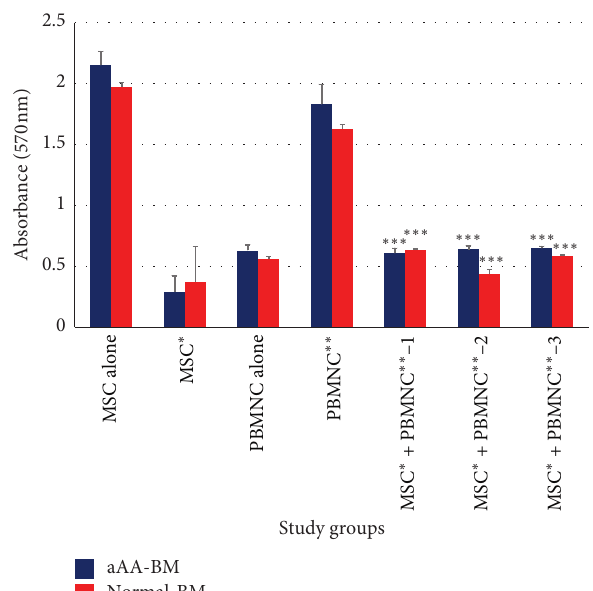
Figure 5: Bar graph representation of one-way mixed lymphocytes reaction (MLR) after establishing cocultures of PBMCs, normal BM, PBMCs, and aAA-BM ( n � 3). PBMNC ∗∗ corresponds to PHA stimulated PBMNCs versus MSC ∗ +PBMNC ∗∗ (coculture) from all three